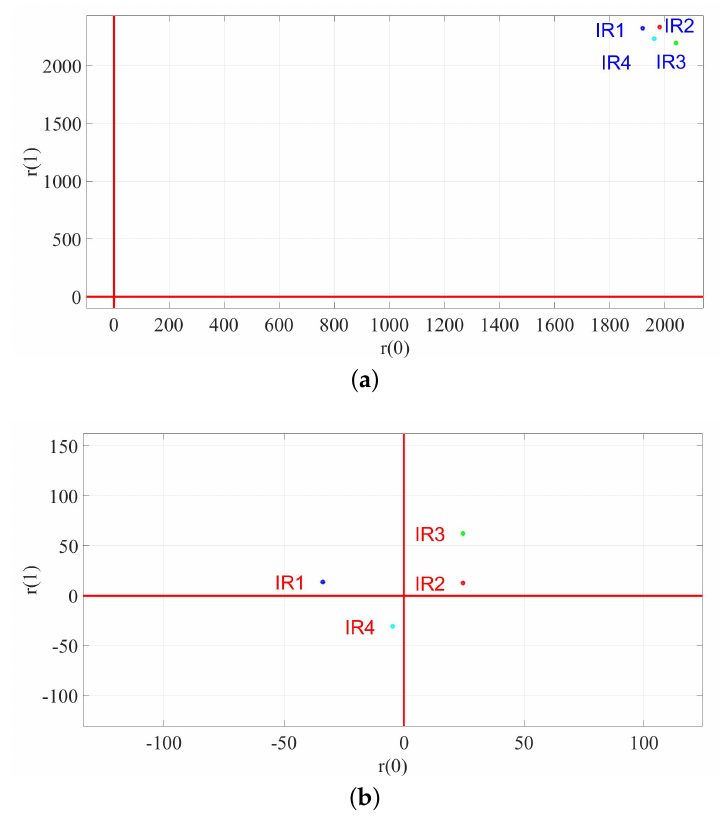
Figure 12. Sammon map results: ( a ) RIR without equalization; ( b ) RIR with